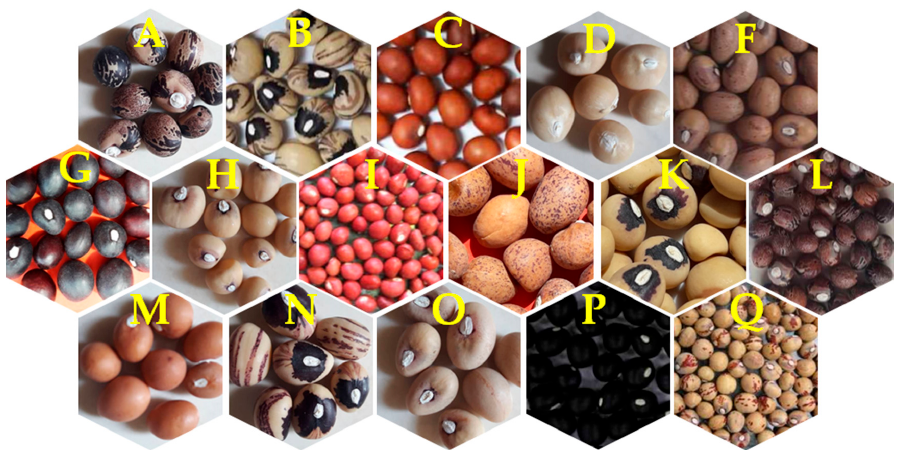
Figure 2. Seed morphological genetic diversity among different landraces of Bambara groundnut ( Note: A =Bidi, B =Maiki, C =Bidilalle, D =Karu, F =Maizane, G =Doii, H =Ex-Sokoto, I =Jatau, J =Bidiyashi, K =Hawayenzaki, L =Zabuwa, M =Yar-Gombe, N =Maibargo, O =Giwa, P -Dunabaki, Q =Cancaraki). The landmass of a country is usually made up of predominantly different soil types [56] and the variation in soil types may contribute to the diversity of Bambara groundnut. In addition to autogamy